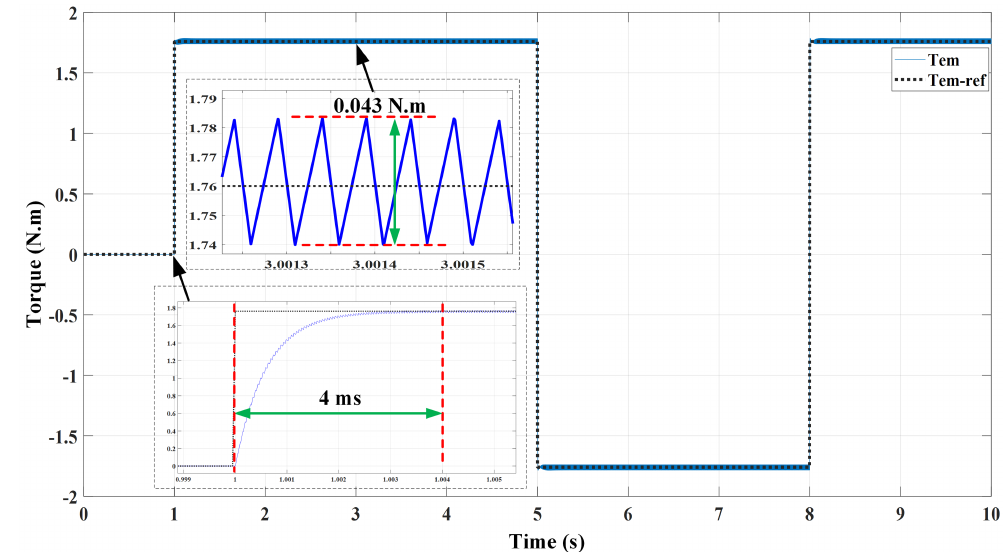
Figure 16. The testbed behaviour of the FOC algorithm for torque